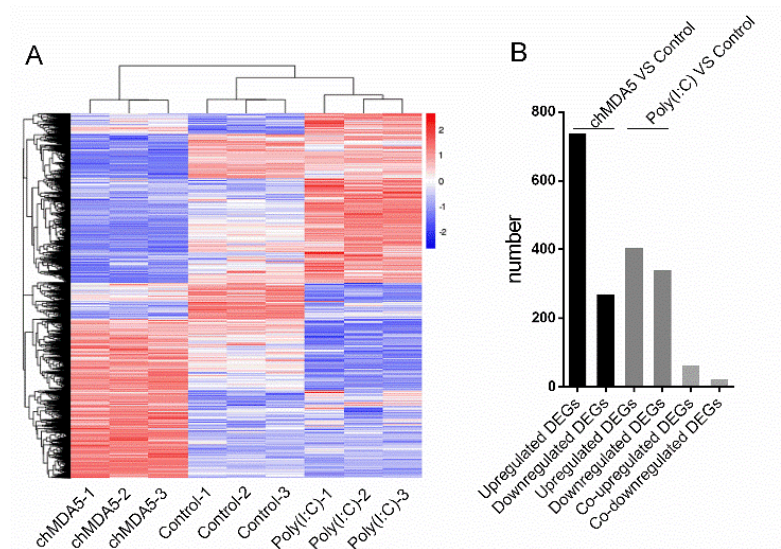
Figure 2. Analysis of di ff erently expressed genes (DEGs). ( A ) Heat map analysis for classifying gene expression patterns. We took log2(FPKM + 1) for the expression of di ff erentially expressed genes by H-cluster method and clustered them after centralized correction. The di ff erentially expressed genes were divided into clusters, and the genes in the same cluster showed similar expression level variation trend under di ff erent treatment conditions. The x -axis indicates the experimental condition. Red color indicates high gene expression and blue indicates low gene expression. ( B ) Summary of the DEGs in chMDA5 and poly(I:C) group compared with control. The x -axis represents di ff erent terms, and the y -axis represents the number of DEGs.